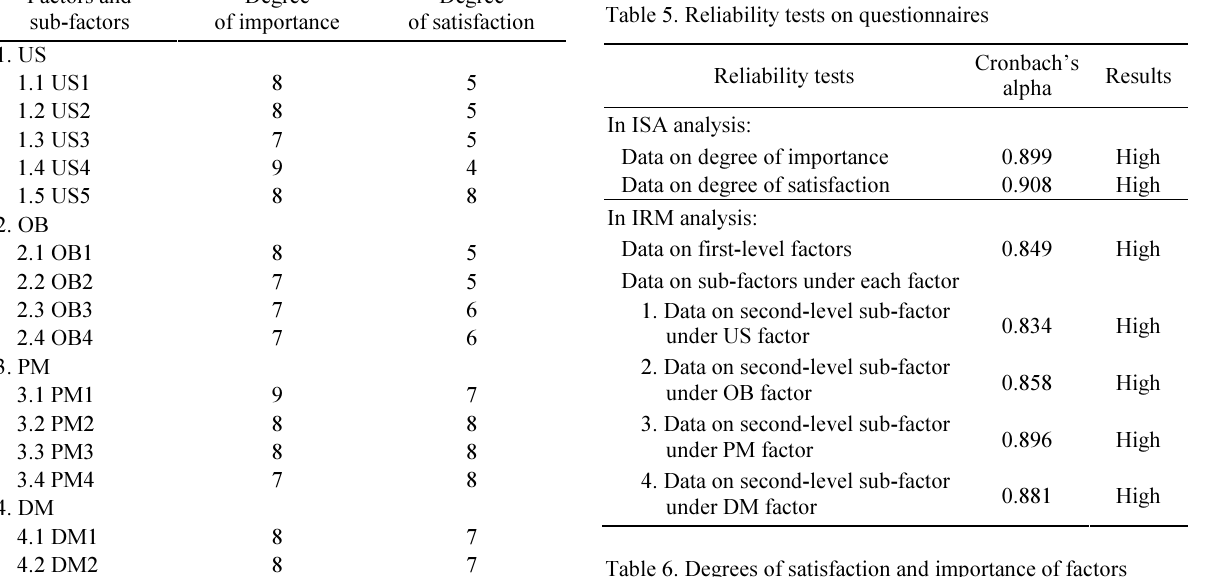
Table 6. Degrees of satisfaction and importance of